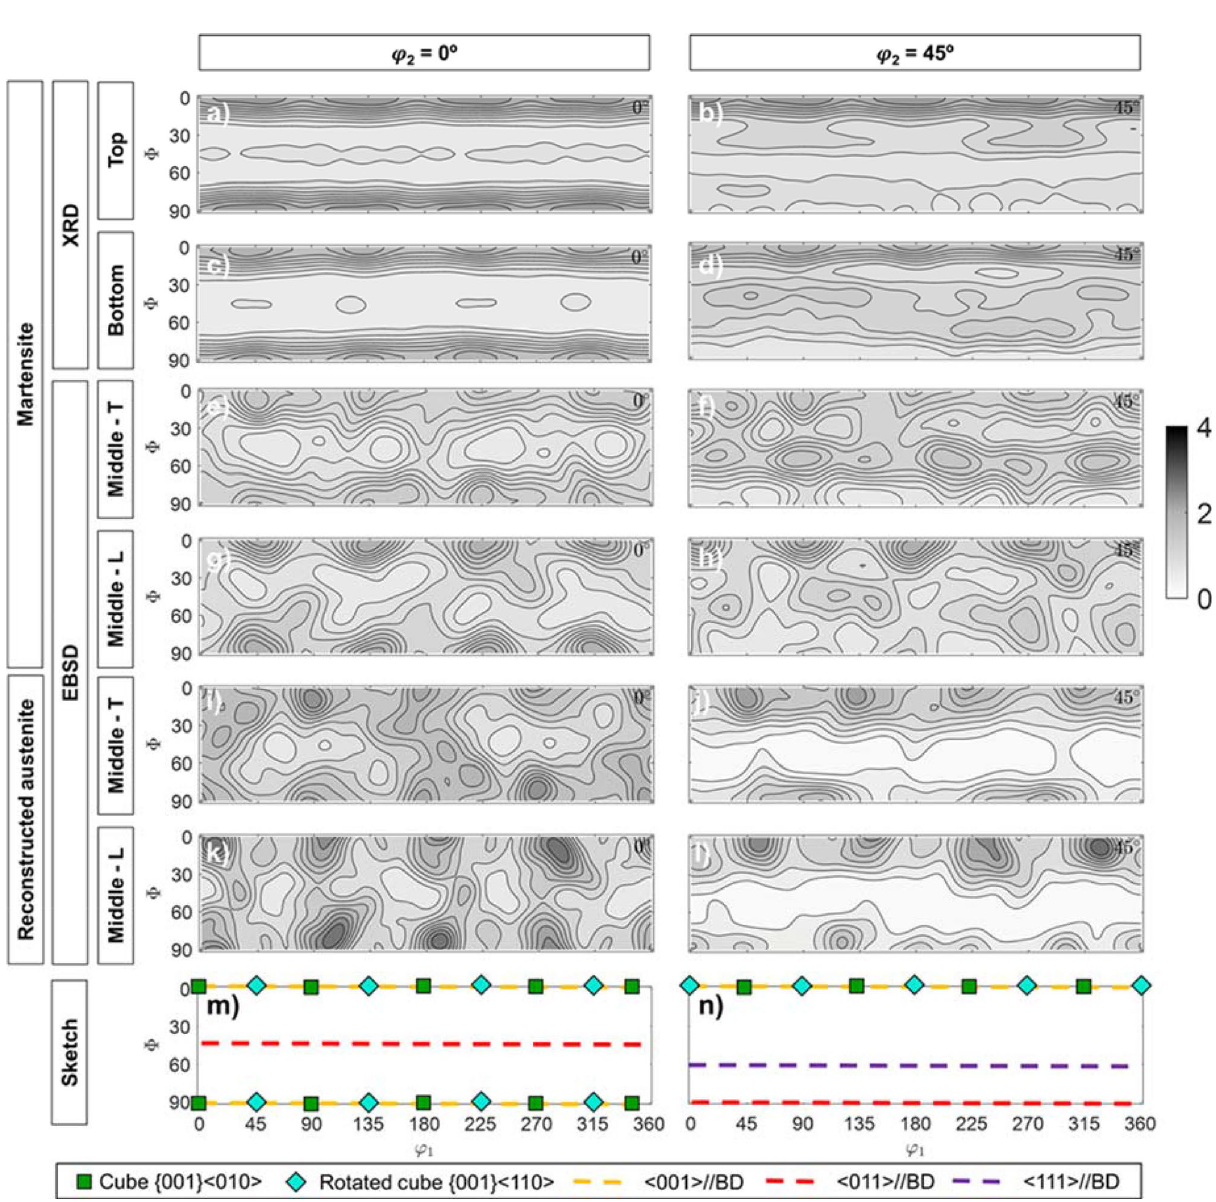
the bcc sub-block boundaries (defined as areas where the misorientation angle values were lower than 6°) are represented by thinner black solid lines. Both correlative SEM-EBSD analyses are useful to understand the printing process. With respect to the transverse section, Fig. 7a shows two different MP boundaries, which implies that the cutting section was below the MP overlap region. Also, it is shown how a cellular colony grows perpendicular to the right MP boundary towards the MP on the right-hand side, suggesting that this MP was formed after the one on the left-hand side. The fact that cellular colonies tend to grow as perpendicular as possible to the MP boundary (along the heat flux) 35 , suggests that the left MP was re-melted during the printing process. With respect to the prior fcc grains, Fig. 7c evidences, once again, the epitaxial growth of the prior austenite grains across the MP boundary, where most of the prior fcc grains have irregular shapes and their size does not vary when approaching the MP bound- ary. In the highlighted case, the cellular colony growth direction does not keep its growth direction when crossing the MP boundary, but it apparently rotates by 90°.